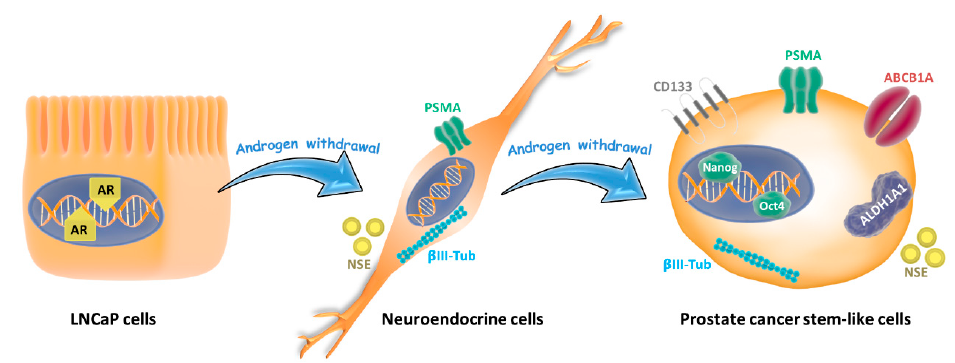
Figure 7. Lineage plasticity in prostate tumor cells induced by androgen depletion. Androgen-sensitive prostate cancer cells (LNCaP cells) grown in androgen withdrawal undergo a phenotype switching and exhibit neuroendocrine features like neurite outgrowth and expression of neuron-specific